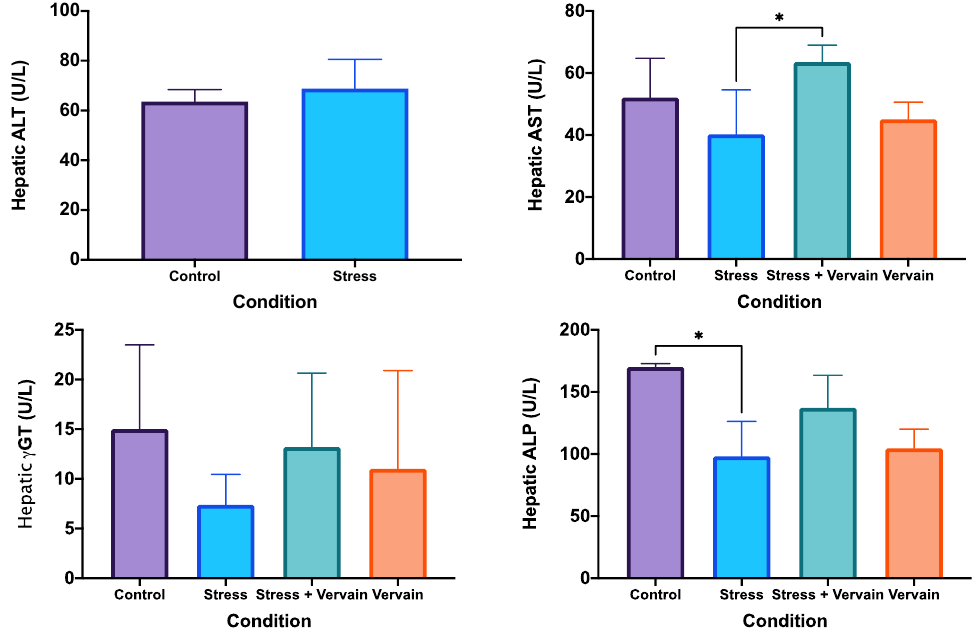
Figure 4. Hepatic enzymes ALT, AST, ALP, and γ GT levels in liver homogenates. * — p ≤ 0.05 .